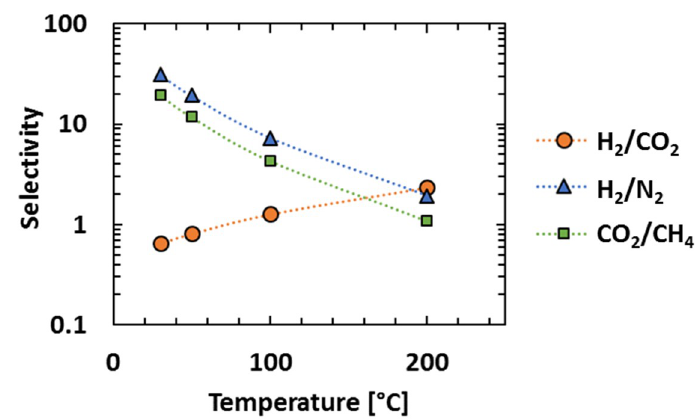
Figure 8. H 2 /CO 2 separation performances of PBI (Cross), Matrimid (Square) and PIM-EA(H 2 )-TB (circle) at 1 bar/30 °C (Black dot) and at 10 bar/200 °C (Red dot). Upper bound at 200 °C recalculated from [7].